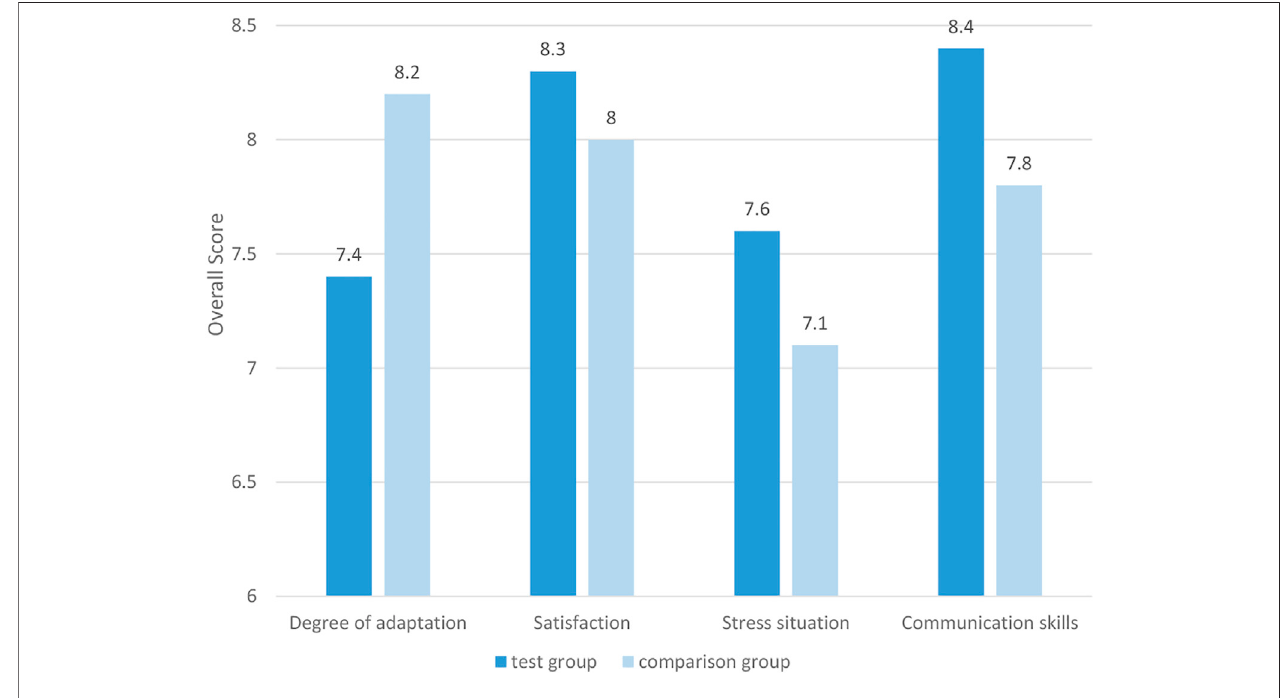
FIGURE 4 | Scores for all aspects of two different teaching methods.